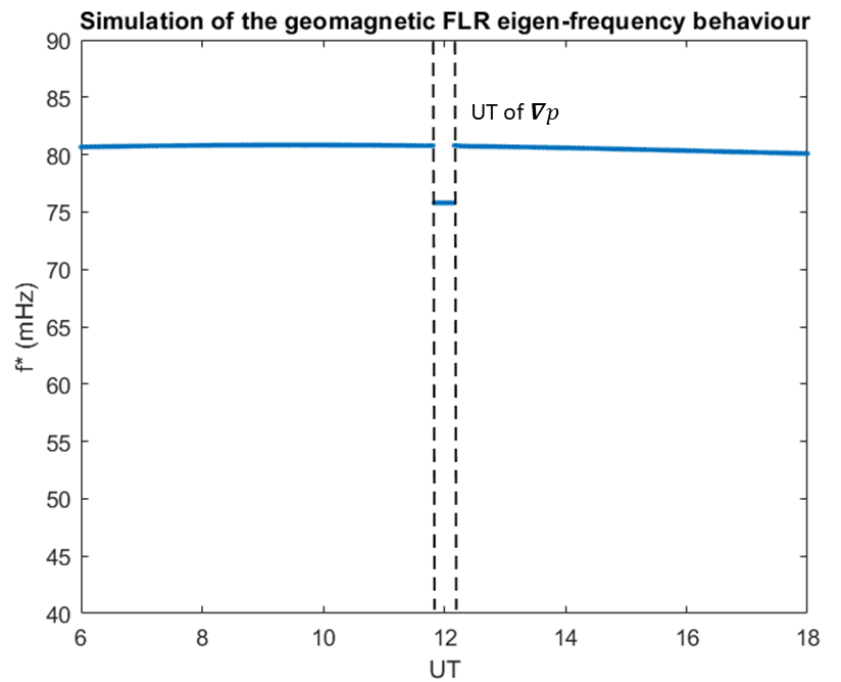
Figure 10. The FLR variation expected for the 14 August 2021 Haitian EQ as predicted by the MILC model. f* represents the modelled magnetospheric field line eigenfrequency.